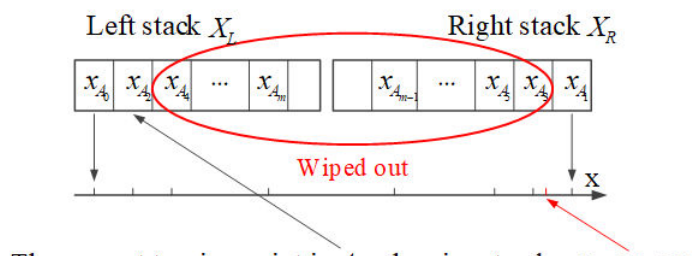
Figure 5. Locate x with the binary